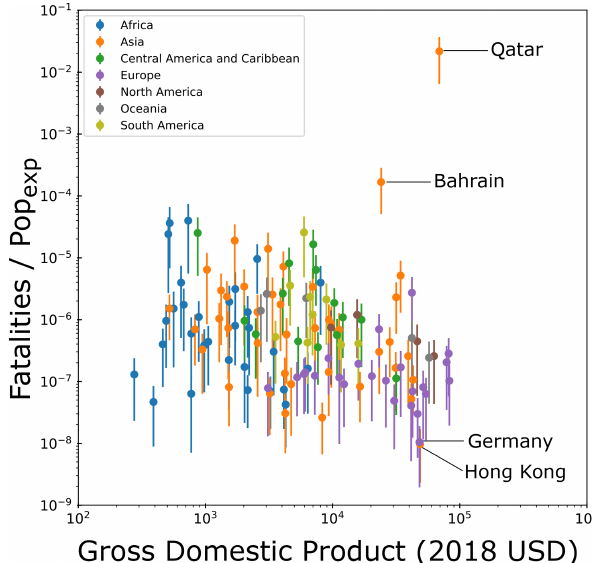
Figure 8. Gross domestic product per capita (World Bank, 2018) compared with the number of landslide fatalities per unit